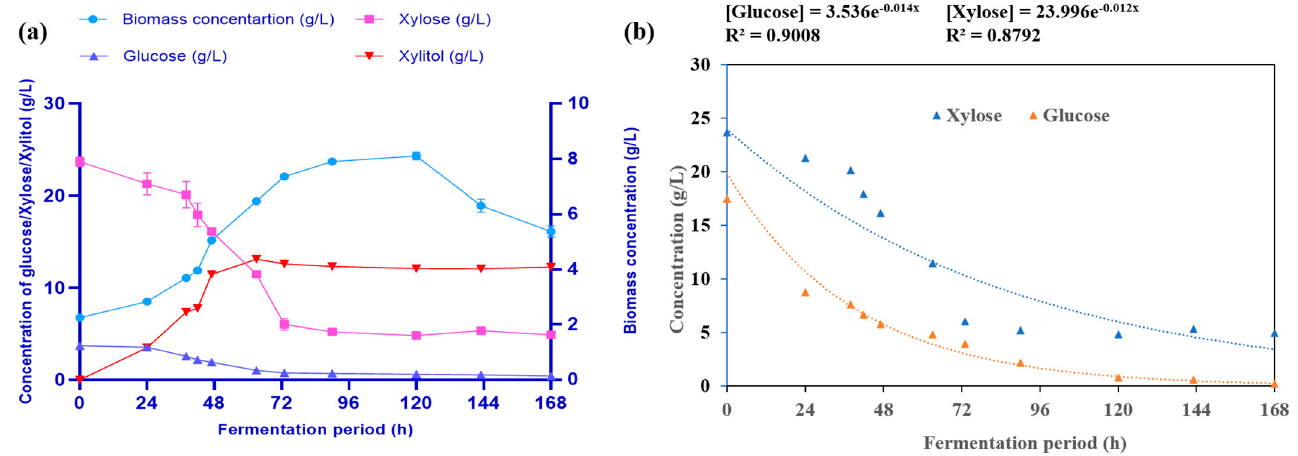
Figure 4. ( a ) Fermentation profile of hemicellulosic hydrolysate for xylitol production under microaerophilic free-cell conditions. ( b ) Substrate (glucose and xylose) consumption profile (based on first-order rate).